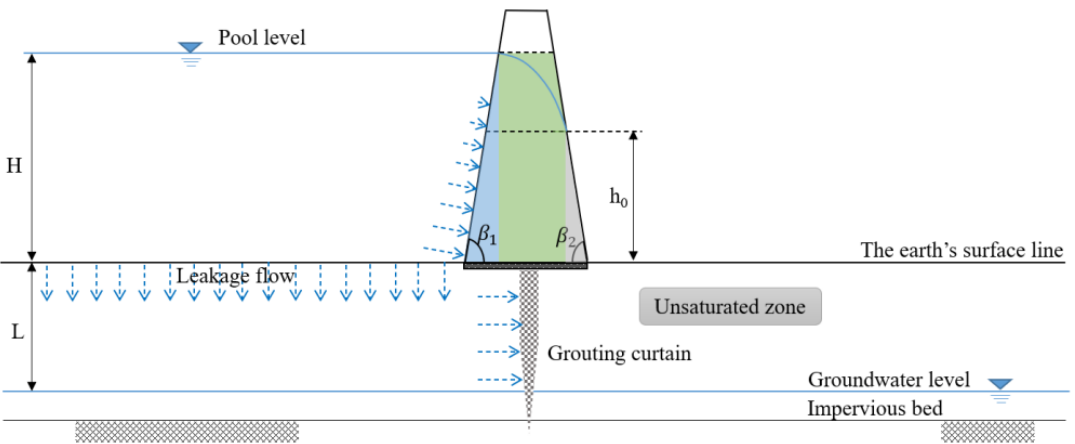
Figure 4. The cross-section of the core. In the upstream section, the triangular region can be transformed into an equivalent rectangular region for the convenience of seepage flux calculation. As is shown in Figure 5,